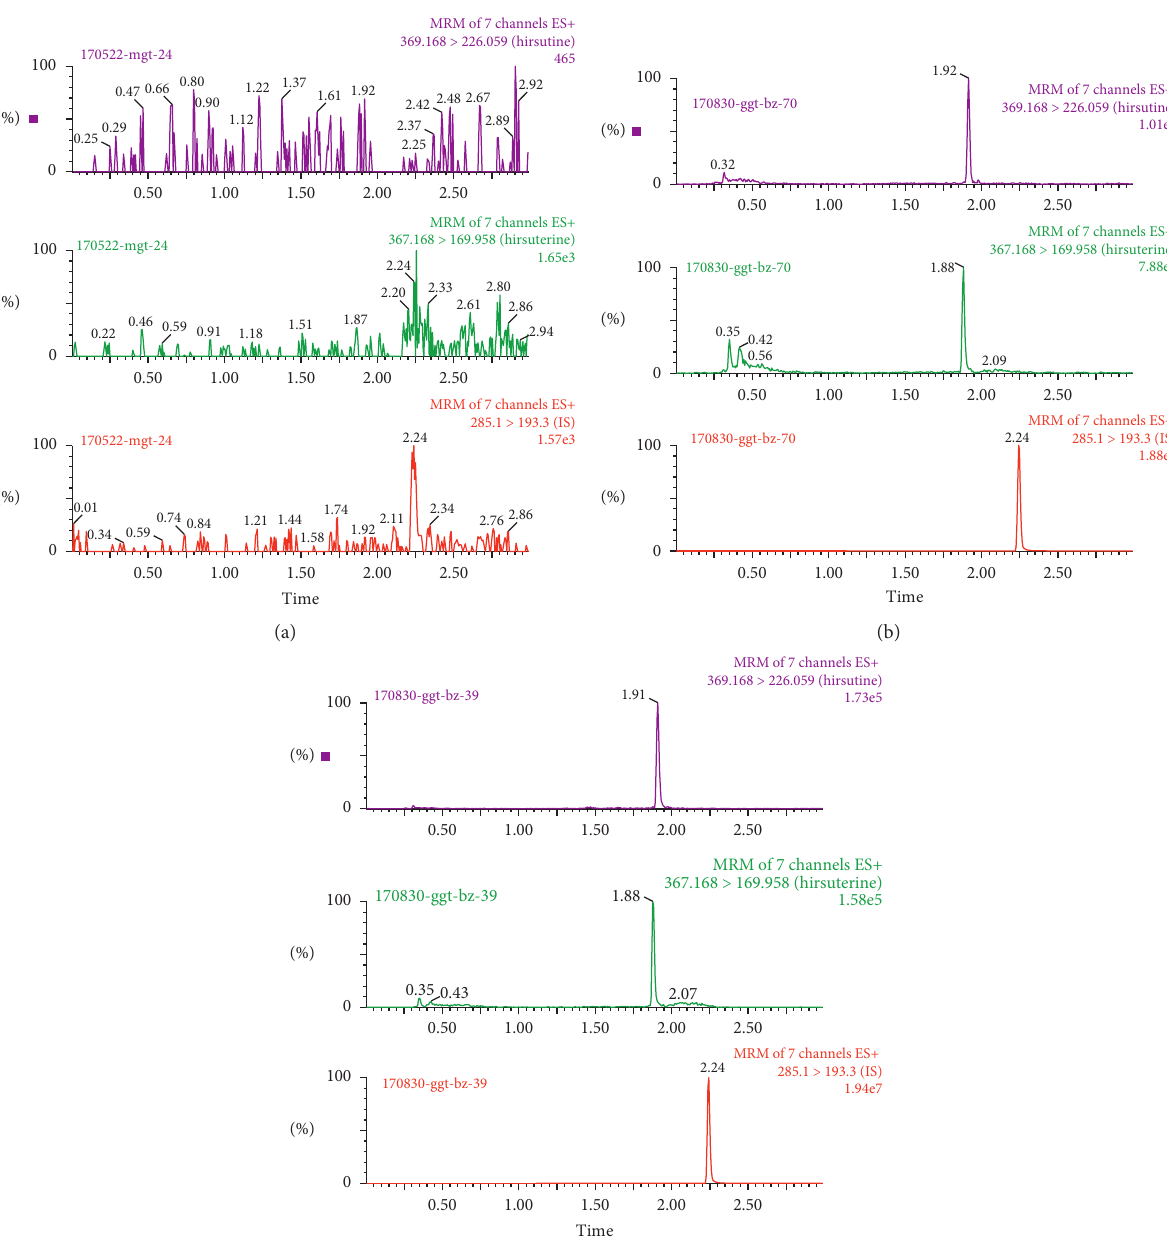
Figure 1: UPLC-MS/MS spectra of hirsutine, hirsuteine, and internal standard in mouse liver. (a) Blank tissue. (b) Blank liver spiked into hirsutine, hirsuteine, and internal standard. (c) A liver sample of mice injected intraperitoneally with 10mg/kg of hirsutine and